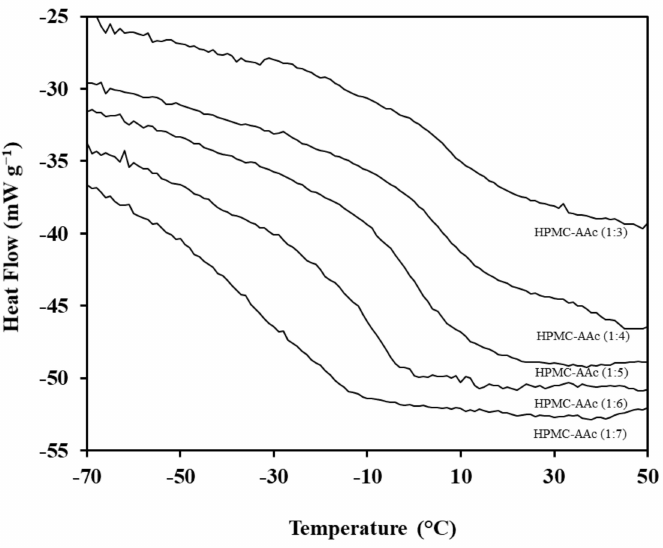
Figure 6. Differential scanning calorimetry thermograms of HPMC-AAc networks (1:7, 1:6, 1:5, 1:4, 1:3); scan rate 1 ◦ C min − 1